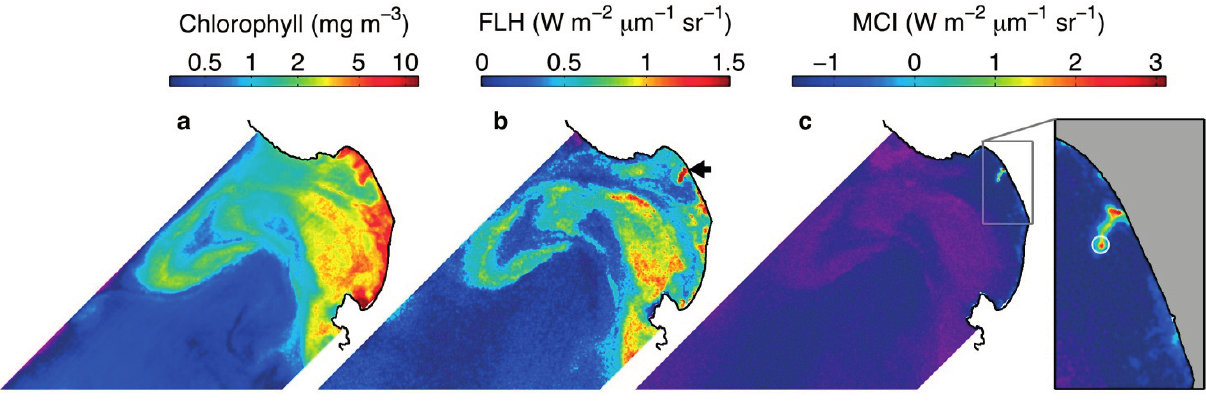
Figure 7. Fall 2011 study: Distinguishing a “red tide” bloom patch with HICO spectral and spatial resolution; MCI is Maximum Chlorophyll Index (Section 2.2). The HICO image was collected on 26 October 2011 at 15:33 local time. The white circle in the MCI map (panel c, zoom) defines the center location for which 3 × 3 pixel mean spectra are presented (Figure